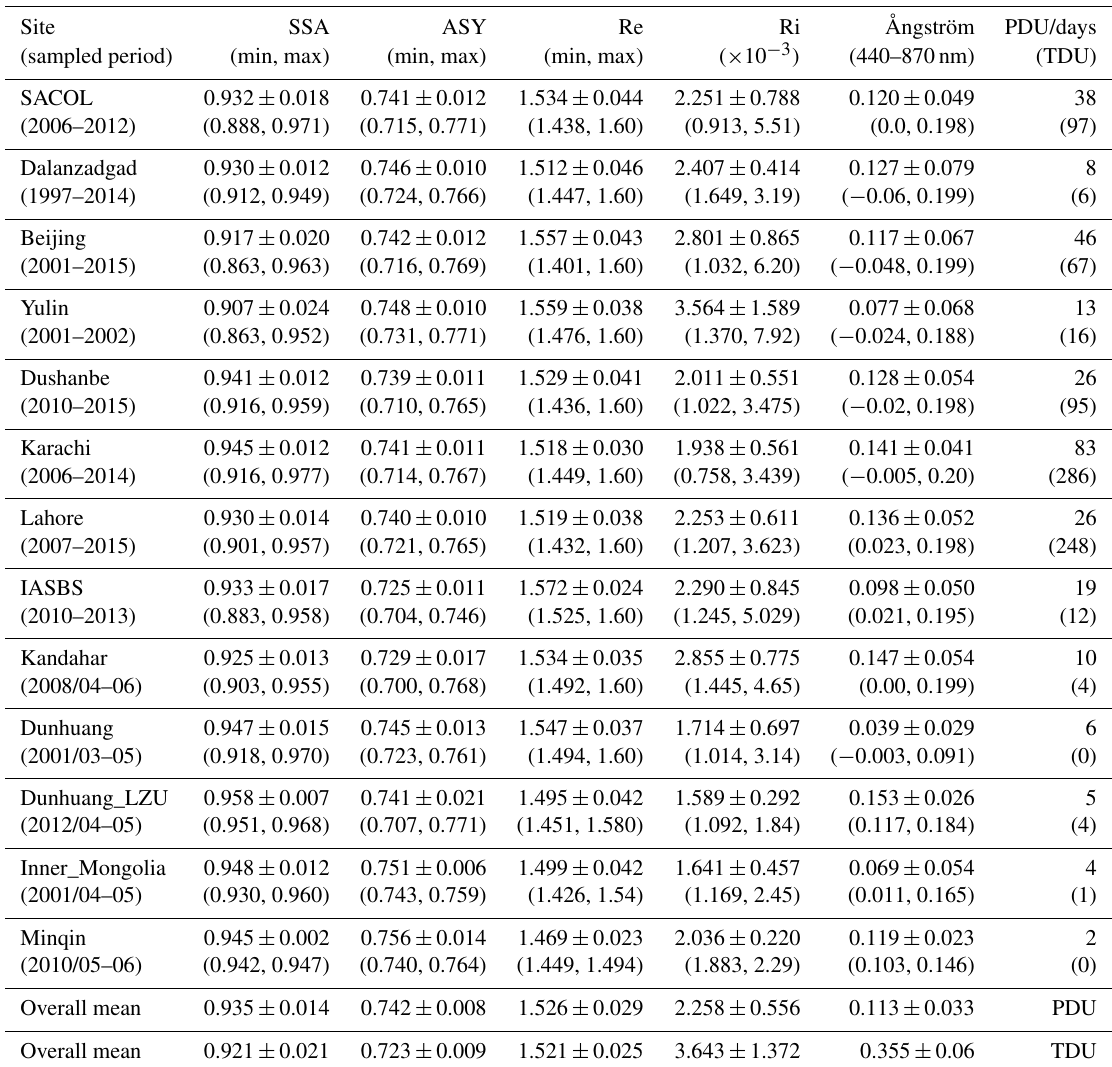
Table 1. Overall average and standard deviation of key optical properties at 550nm (e.g., single-scattering albedo, asymmetry factor, and real part and imaginary part of complex refractive index) for Asian Pure Dust (PDU). Ångström wavelength exponent ( α) is in the range of 440–870nm. Minimum and maximum values of the optical properties are in parentheses for each corresponding column. Measuring period and the total number of PDU ( α <0.2) and TDU (0.2< α <0.6) days are in parentheses for the first and last column,